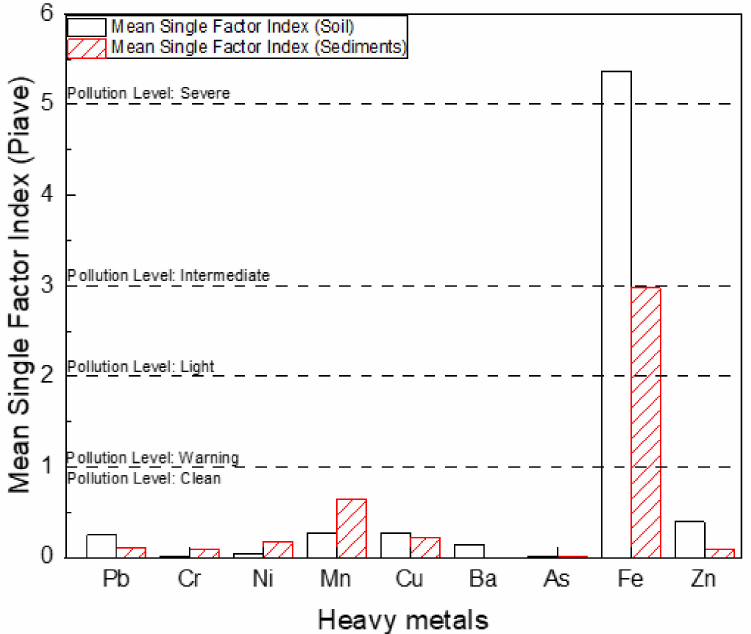
Figure 3. Mean Single Factor pollution index of Pb, Cr, Ni, Mn, Cu, Ba, As, Fe, and Zn for soil and sediment.